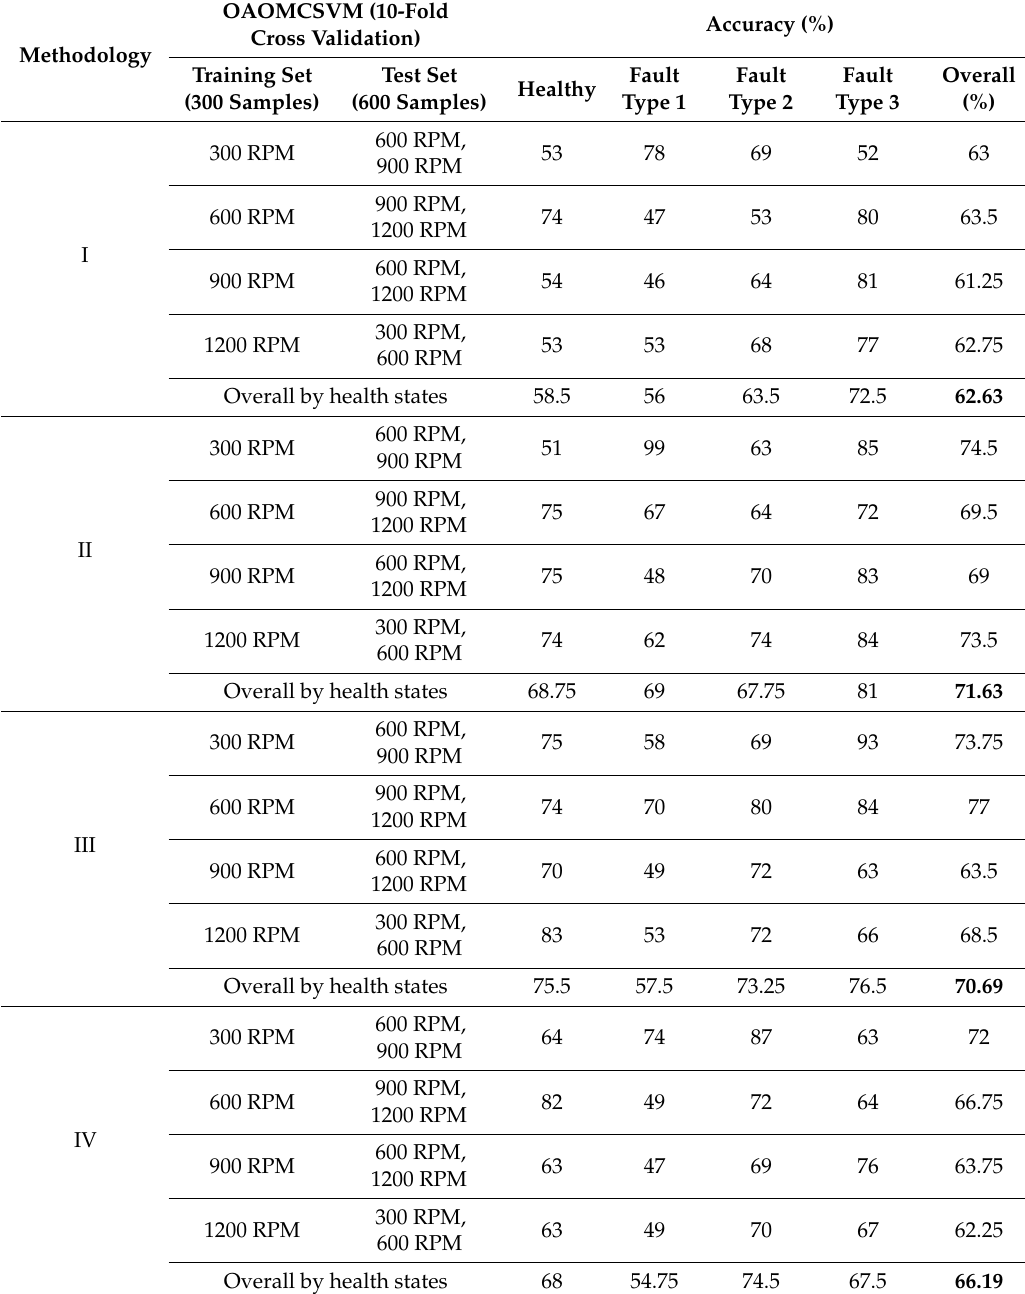
Table 5. Classification results for state-of-the-art methodologies and the proposed ANR-GRS methodology by observation of separated speed